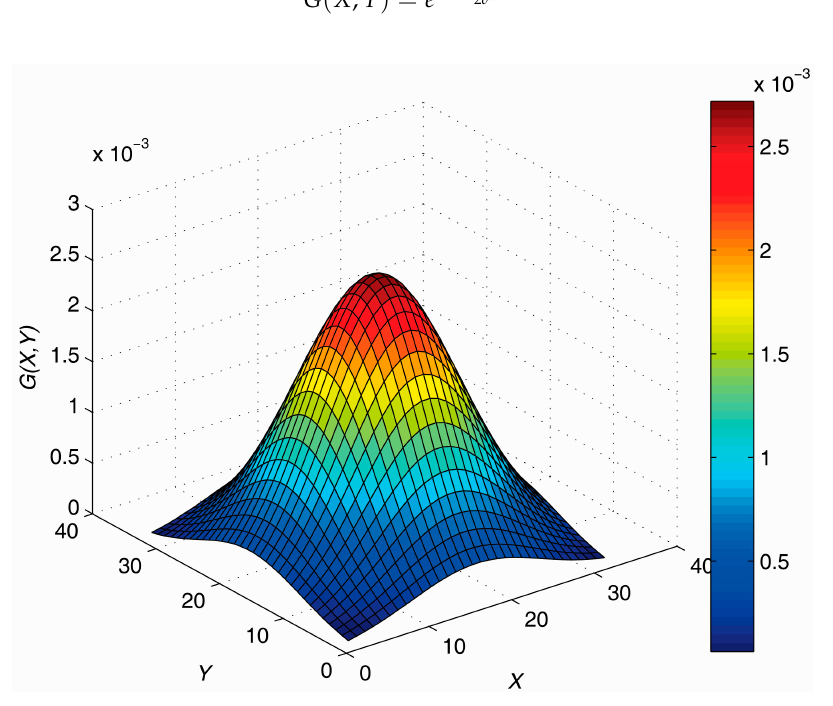
Figure 8. Gaussian low-pass filter.